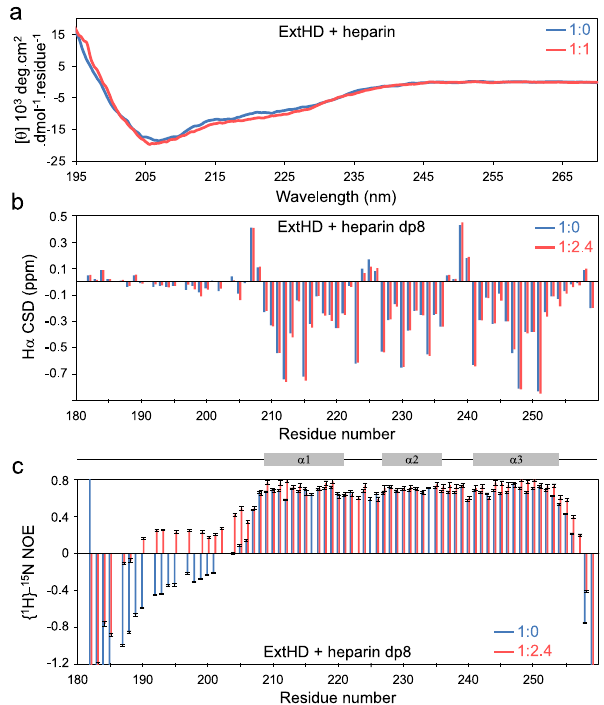
Fig.4|TheGAG-bindingregion189-204ofEngrailed2remainsdisorderedupon binding to heparin or heparin fragments. a CD spectra of ExtHD in the absence (blue) and presence (red) of 1 molar equivalent 12kDa heparin. Chemical shift deviations (CSD) and { 1 H}- 15 N NOEs of ExtHD recorded at 500MHz in the absence (blue) and presence (red) of 2.4 molar equivalents heparin dp8 are shown in b , c ,respectively.Errorbarsin c indicatethestandarderrorforeachvaluebasedon peak intensity relative to background noise (see the “ Methods ”